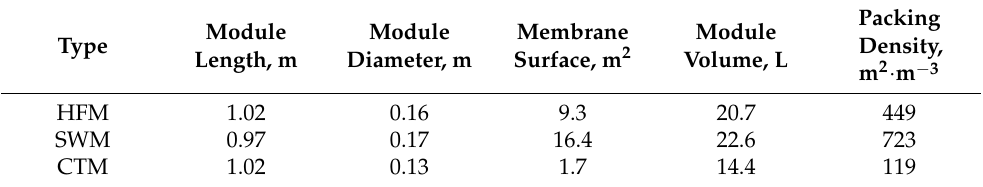
Table 2. Module dimensions of hollow fiber membrane (HFM), spiral wound membrane (SWM), and ceramic tubular membrane